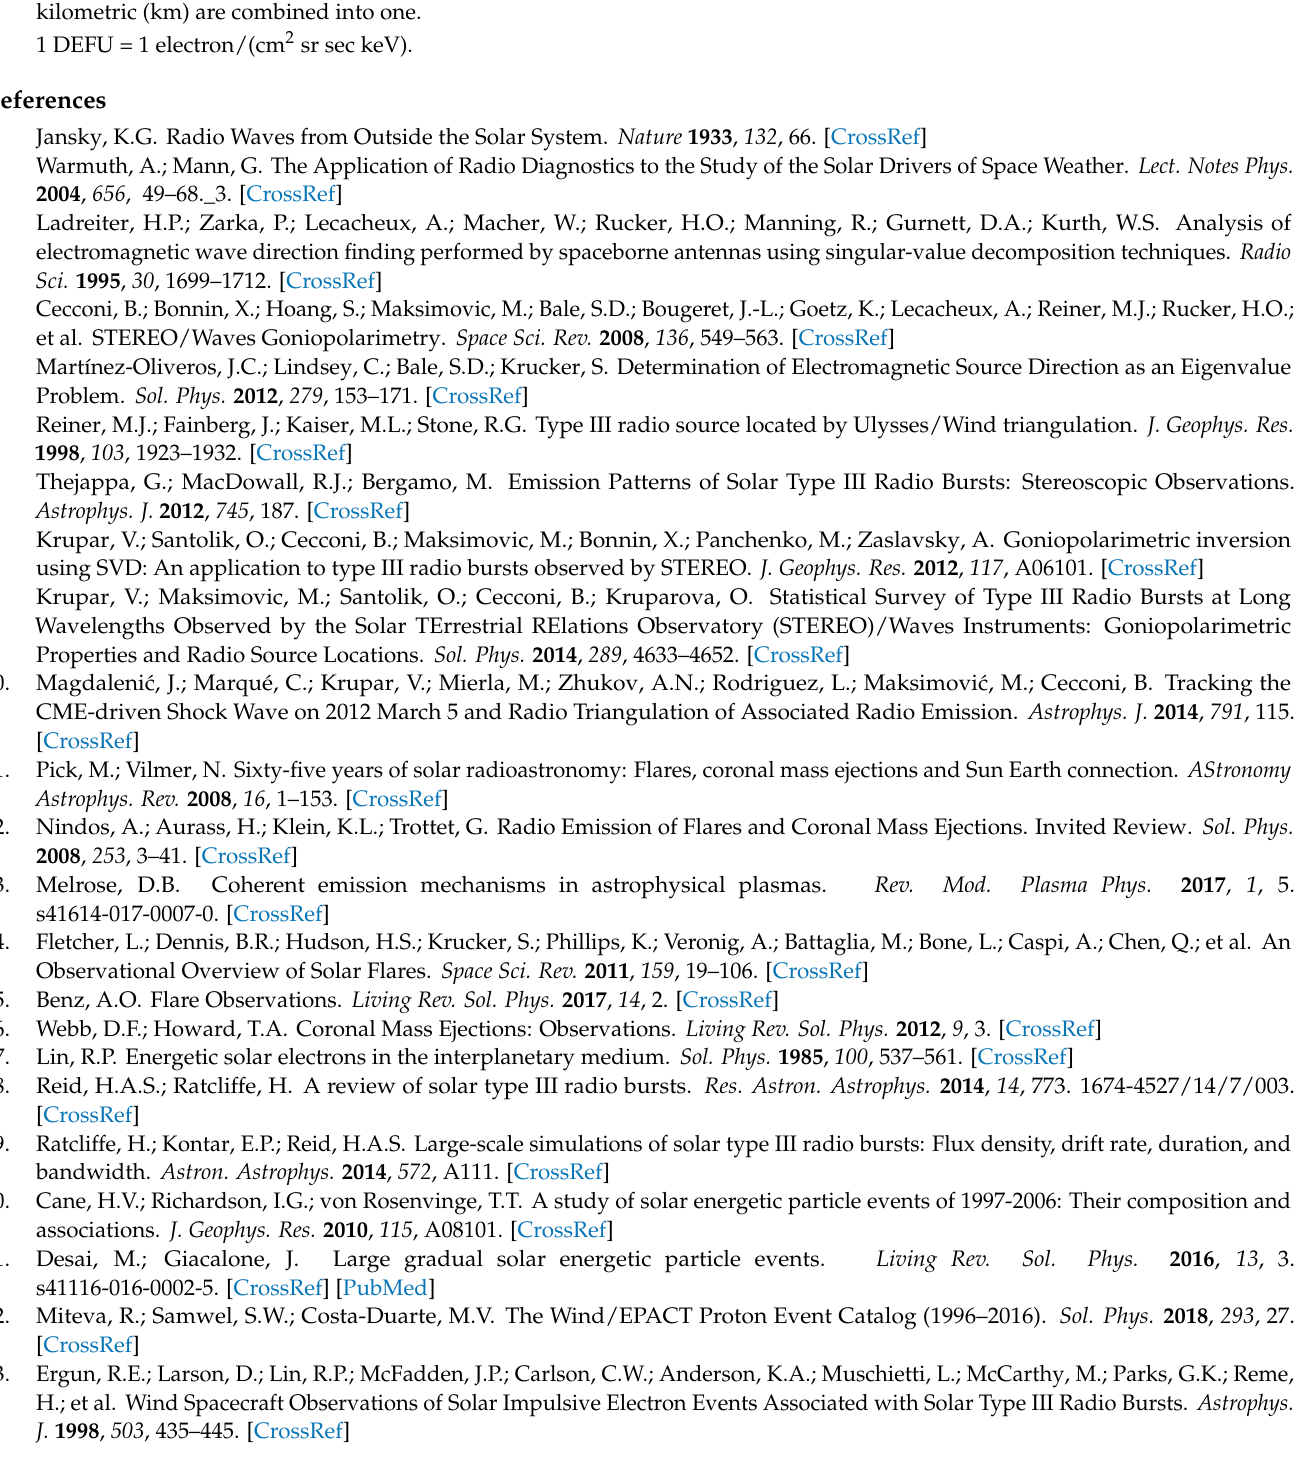
kilometric (km) are combined into